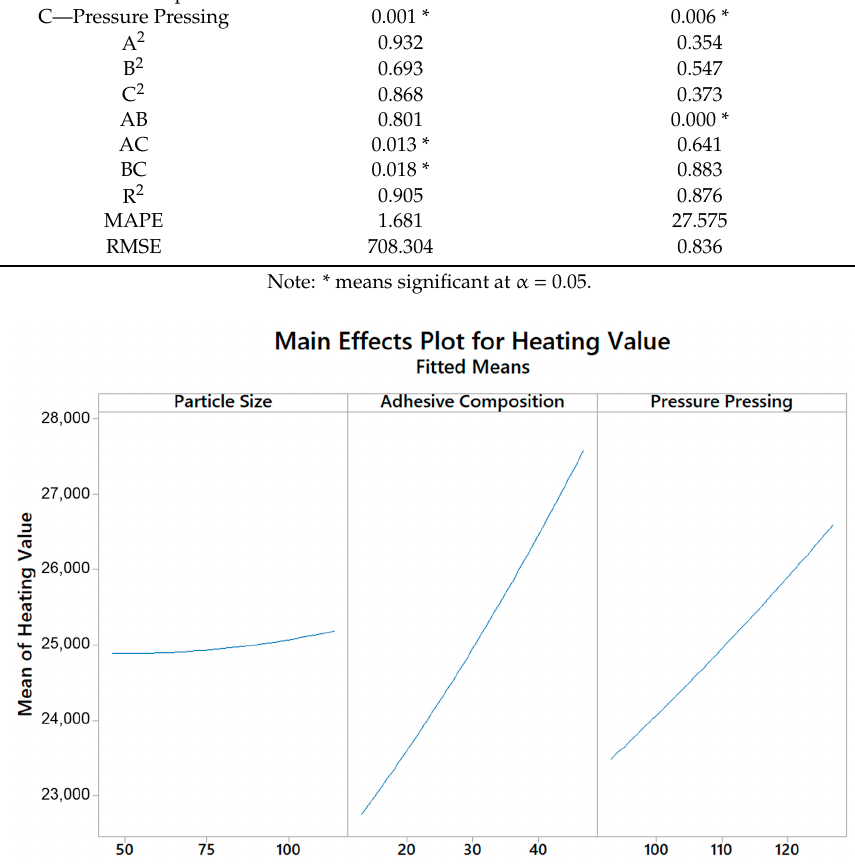
Figure 3. The main effect of process conditions on the heating value. Processes 2020 , 8 , x FOR PEER REVIEW